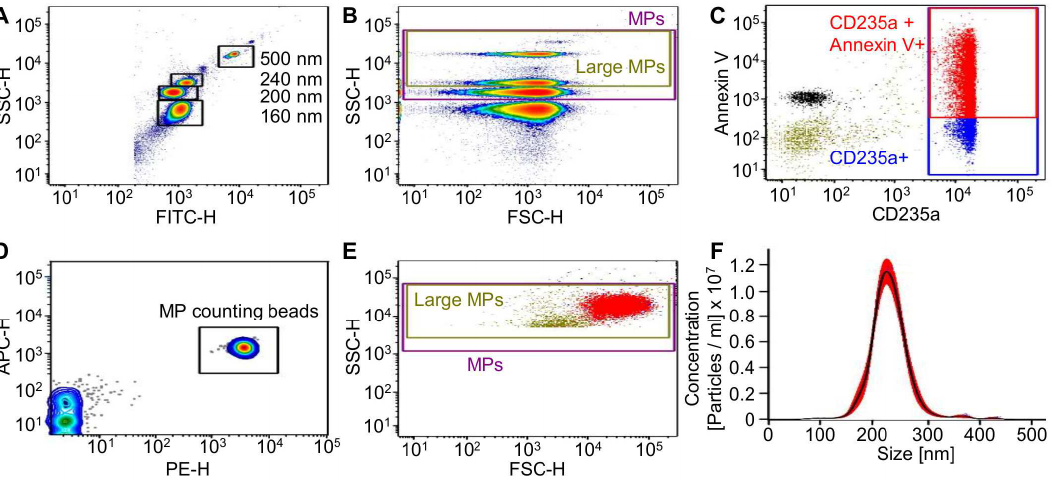
Figure 1. Quantification of red blood cell-derived microparticles (RMP). ( A – E ) Flow cytometer (FC) settings and gating strategy for RMP quantification with Megamix-Plus SSC and MP-Counting Beads (0.3 µm sized PE fluorescent beads). Shown are density/dot blots from one representative measurement out of 32 independent analyses. SSC-H vs. FITC-H ( A ) and SSC-H vs. FSC-H ( B ) density blot showing the location of the Megamix-Plus SSC beads. Beads were used to set up the SSC- H, FITC-H and FSC-H PMT voltage ( A , B ), the MP gates ( B ) and the SSC threshold for RMP analysis. ( C ) Gating strategy to characterize the RMP population. Dual APC/Annexin V vs. BV450/CD235a scatter dot showing the double stained RMP isolate. RMPs are defined as CD235a and Annexin V positive. ( D ) Dual-APC-H vs. -PE-H density blot showing the location of the MP-Count Beads during sample aquisition. Beads with a known concentration were spiked into each RMP sample. Samples were analyzed at low speed for at least 2 min or to a corresponding minimum of 500 MP-Count Beads. ( E ) SSC-H vs. FSC-H dot blot illustrating the double stained RMP isolate within the prior defined (see ( B )) MP gates. ( F ) Nanoparticle tracking analysis (NTA) of RMP isolates via Nanosight NS500 ( n = 4). Shown is one representative NTA out of four independent analyses of RMP isolates. RMPs were analyzed for phosphatidylserine exposition by Annexin V staining and the RBC marker CD235a. RMPs were counted with 0.3 µm sized PE fluorescent counting